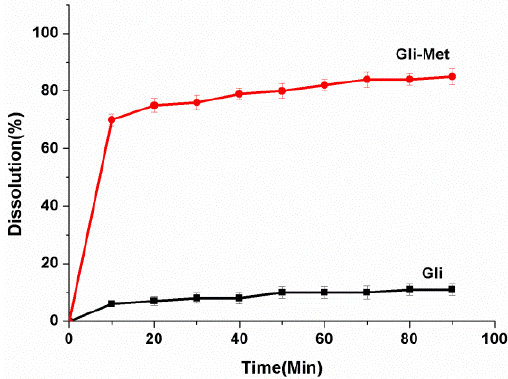
Figure 8. The dissolution rate of Gli-Met and Gli (pH = 1).